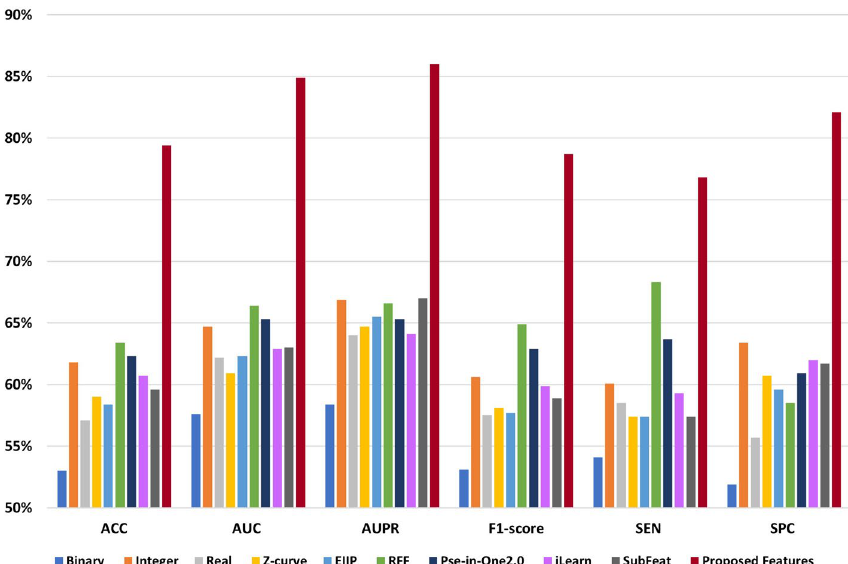
Figure 2. The performance evaluation of the features based on PyFeat with AB compared with other techniques: five numerical representations, RFF, Pse-in-One2.0, iLearn, and SubFeat based on the protein